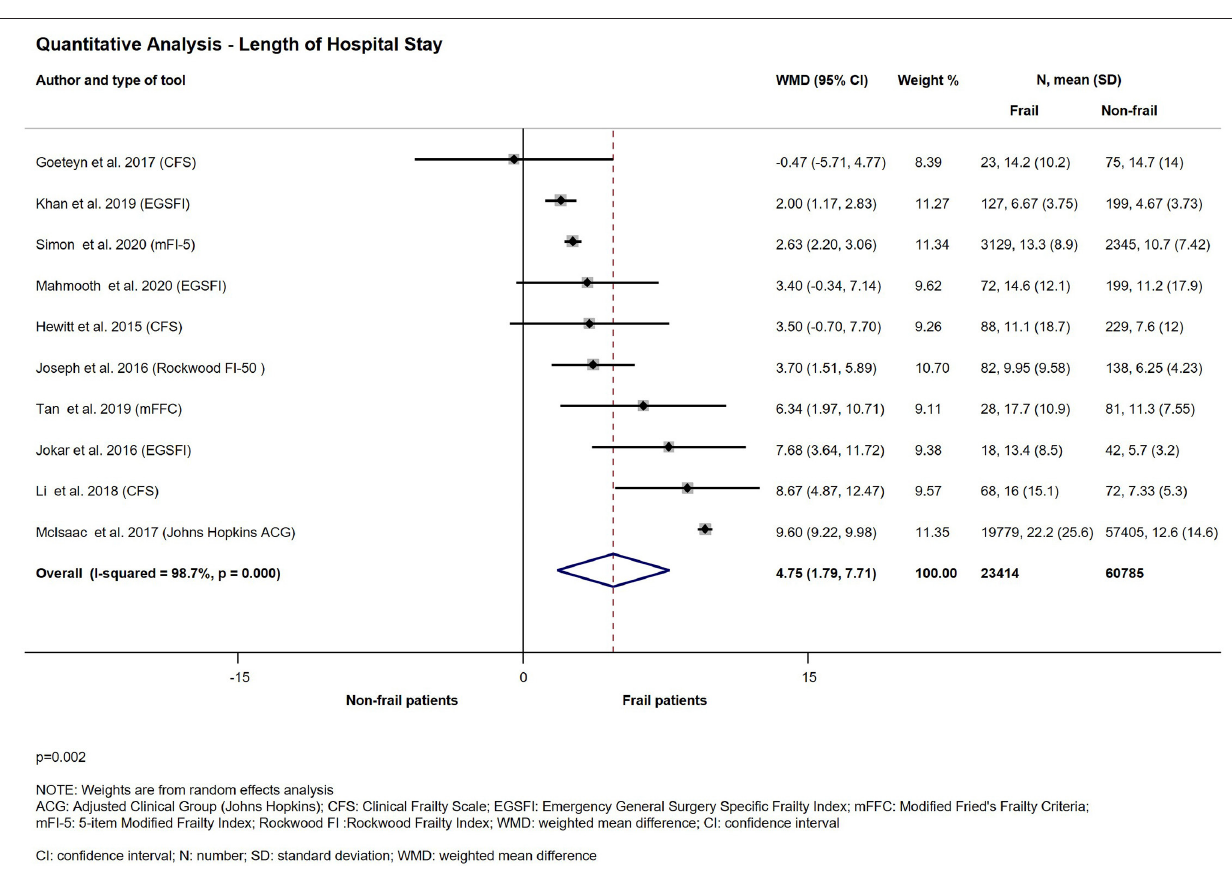
FIGURE 7 | Quantitative analysis—Length of hospital stay for emergency surgical patients living with frailty compared to non-frail patients. Frail patients’ average length of hospital stay was significantly higher than non-frail patients’ (WMD: 4.75; CI: 1.79–7.71). Please note the considerable